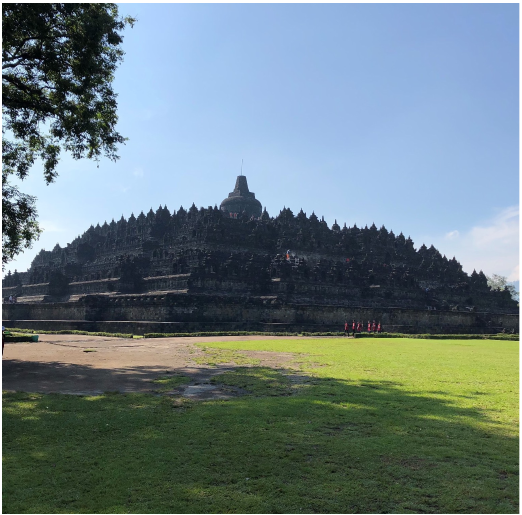
Figure 1. Borobudur Temple in Indonesia